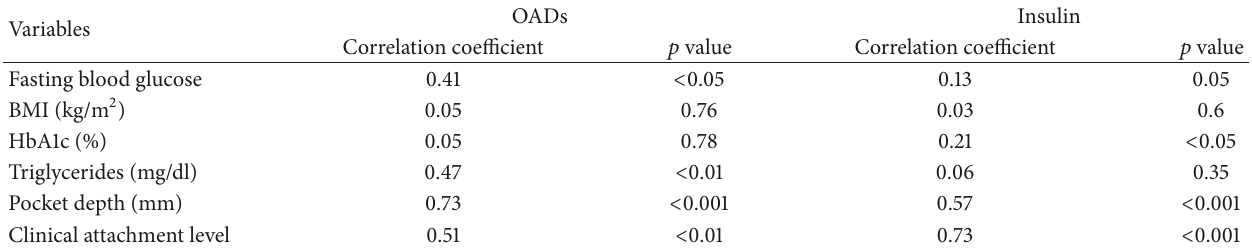
Table 7: Correlation of gingival index with clinical variables based on antihyperglycemic